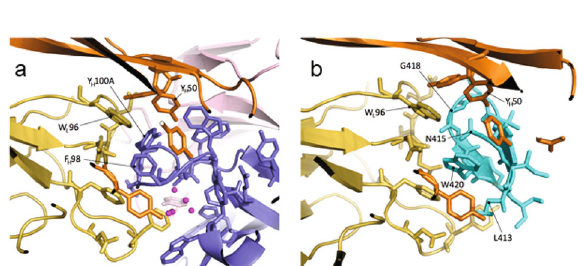
Fig. 2 Antigen mimicry by B2.1 A. a Ab1 – Ab2 complex (AP33 heavy chain: orange, light chain: yellow; B2.1 A heavy chain: blue, light chain: pink) and b Ab1 – Ag complex (AP33 heavy chain:orange, light chain:yellow; peptide:cyan; pdb accession code 4gag). Water molecules are shown as magenta